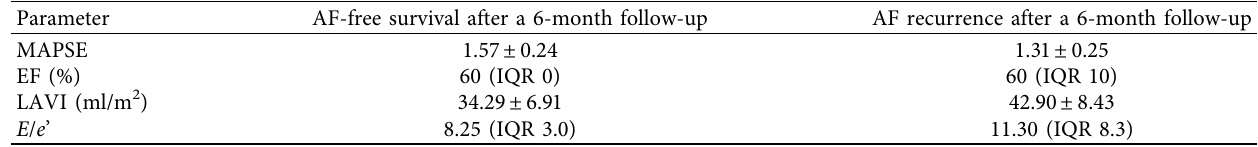
Table 2: Relationship between echocardiographic parameters and AF recurrence after